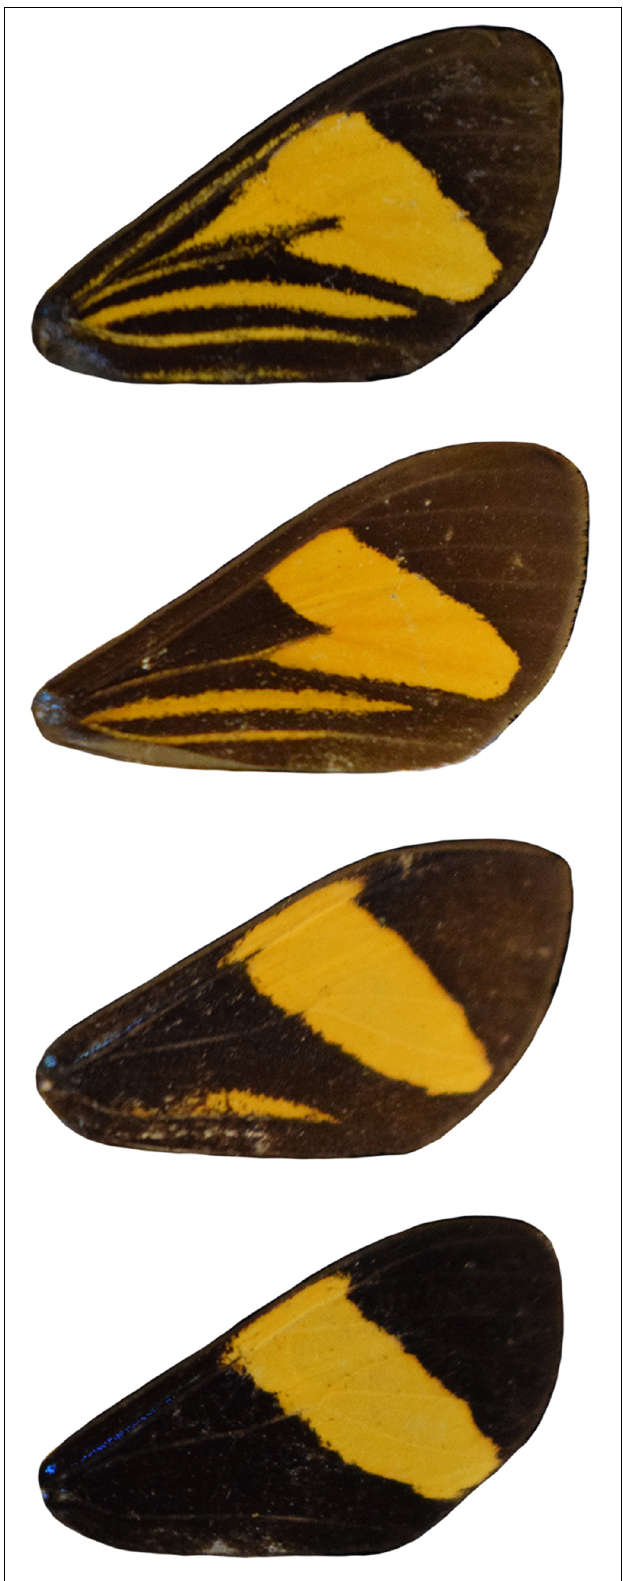
FIGURE 7 | Bold patterns can be produced through the intensification of venous striping. The scheme depicted in Figure 6 suggests that bold patterns are produced from the distal-proximal fusion of primary elements. However, examination of specimens found in museum collections seems